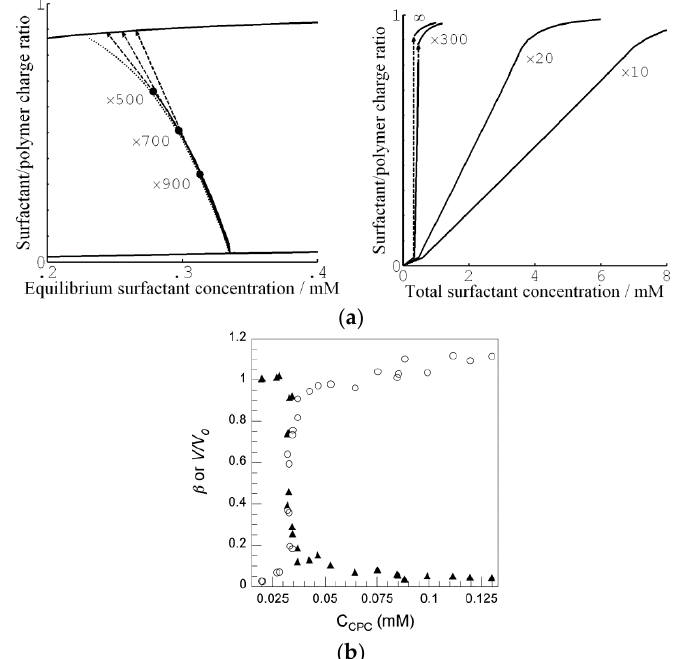
Figure 15. ( a ) Binding isotherms calculated from theory for solution / gel volume ratio as indicated. 10 mM salt. The stable core–shell curves in di ff erent volumes are overlapping, also with the unstable curve of infinite volume (dotted). Filled circles indicate points where the shell is destabilized, inducing a jump indicated by dashed arrows. The discrete jump becomes smaller with reduced volume, eventually disappearing entirely. Figure taken from ref. [74]. Reprinted with the permission of AIP Publishing.; ( b ) Experimental binding and swelling isotherms for C 16 PCl–sodium hyaluronate gel in 12 mM TRIS bu ff er pH 7.4. Acknowledgment: [108].